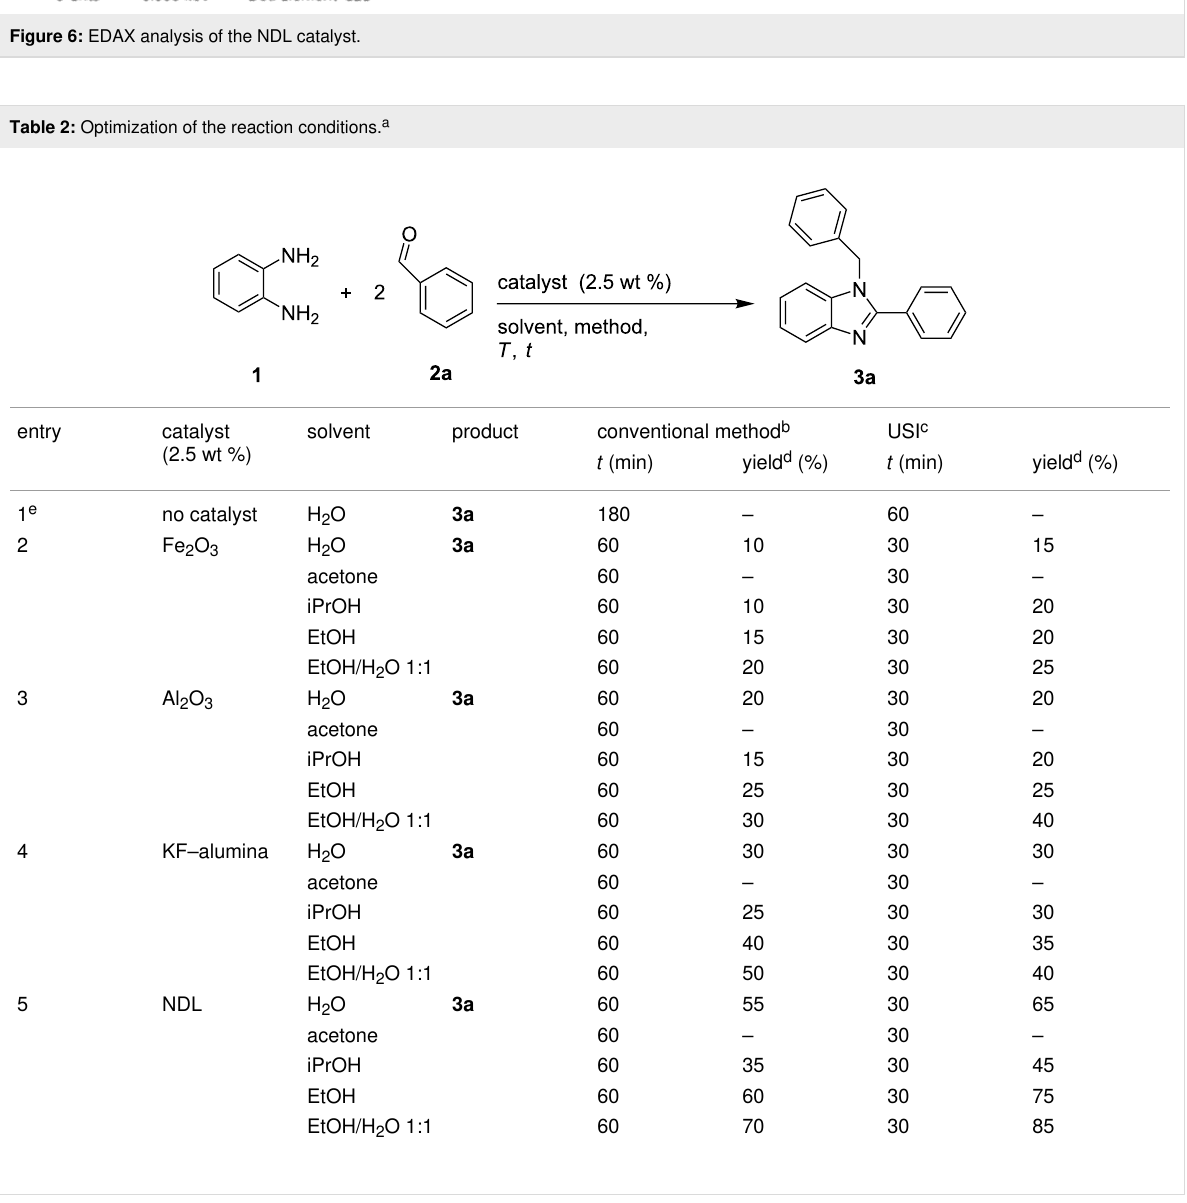
Figure 6: EDAX analysis of the NDL catalyst.